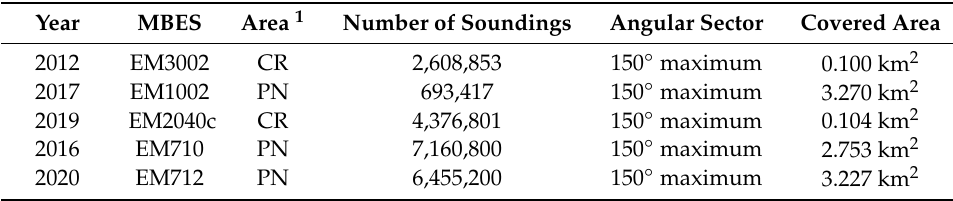
Table 1. Examples of survey on Shom’s reference